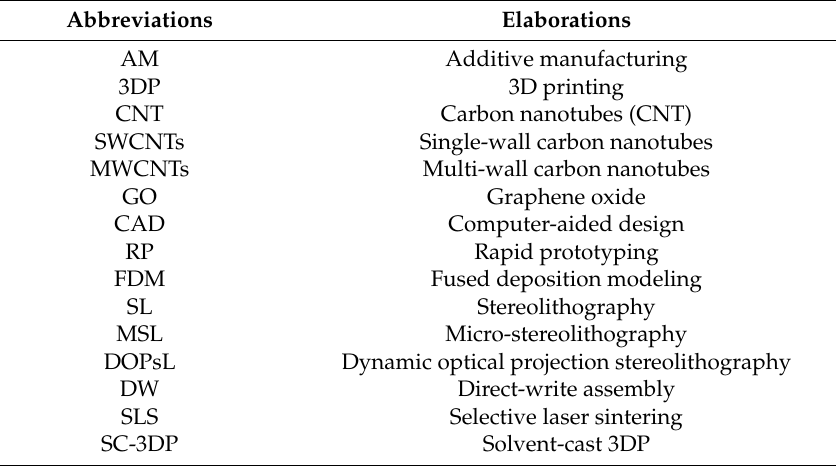
Table 1. Abbreviations and their